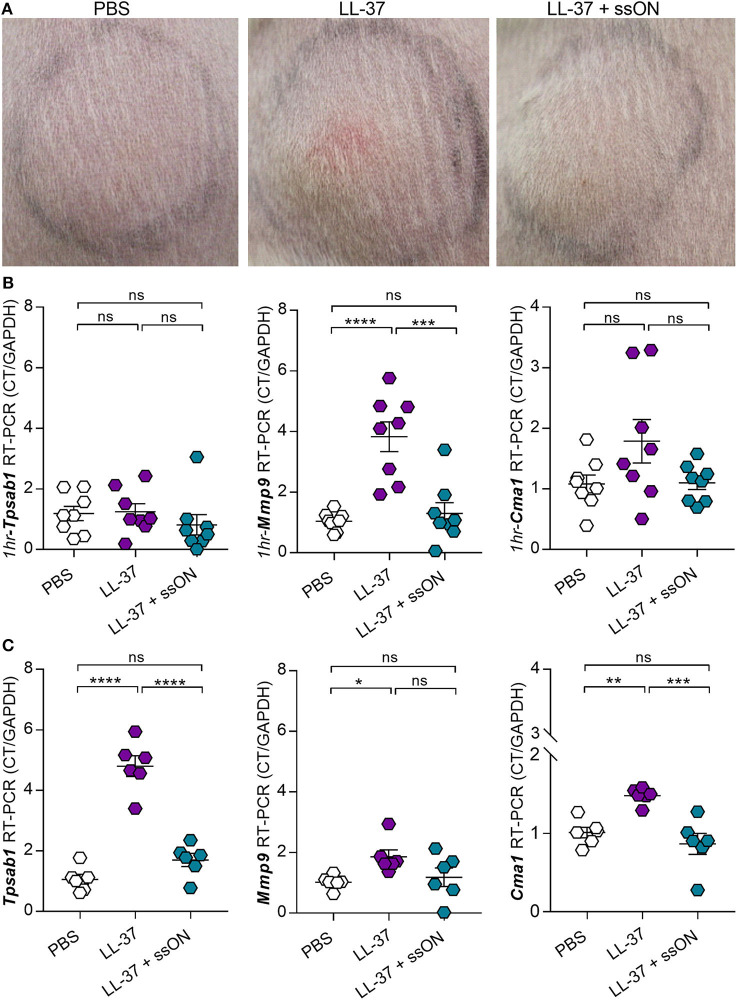
ssON ameliorated LL-37-mediated inflammation in a rosacea mouse model. Mice were treated subcutaneously in the skin of the back with LL-37 (320 μM), with or without ssON (57 μg), or PBS. (A) Photographs for the respective treatments were taken at the clinical endpoint, 72 h after the induction of rosacea-like inflammation. The expression of mouse chymase (Cma1), tryptase (Tpsab1), and matrix metalloproteinase-9 (Mmp9) in the skin was assessed using RT-PCR in biopsies collected (B) 1 h post treatment or (C) 72 h after observation. Representative pictures are shown for each treatment group. Statistical significance was assessed by one-way ANOVA or Kruskal-Wallis test for Tpsab1 expression in C and Mmp9 expression in B. Normality was assessed using the Shapiro-Wilk normality test (GraphPad Prism); N = 8 for (B) and N = 6 for (C). P-value: ****P < 0.0001, ***P = 0.0002–0.0006, **P = 0.0057, *P = 0.033, ns, non-significant. Data is shown as mean ± SEM. 1 h = 1 hour post treatment.